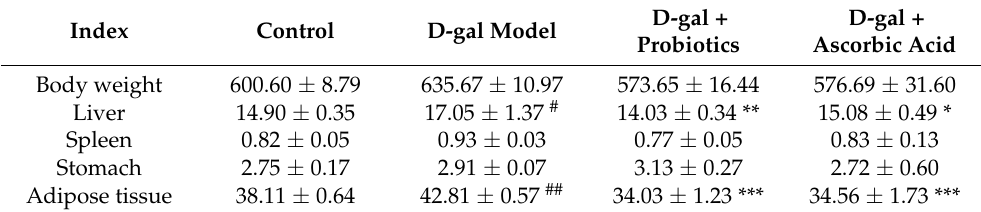
Table 1. Effect of B. animalis MSMC83 on the body and organ weights.